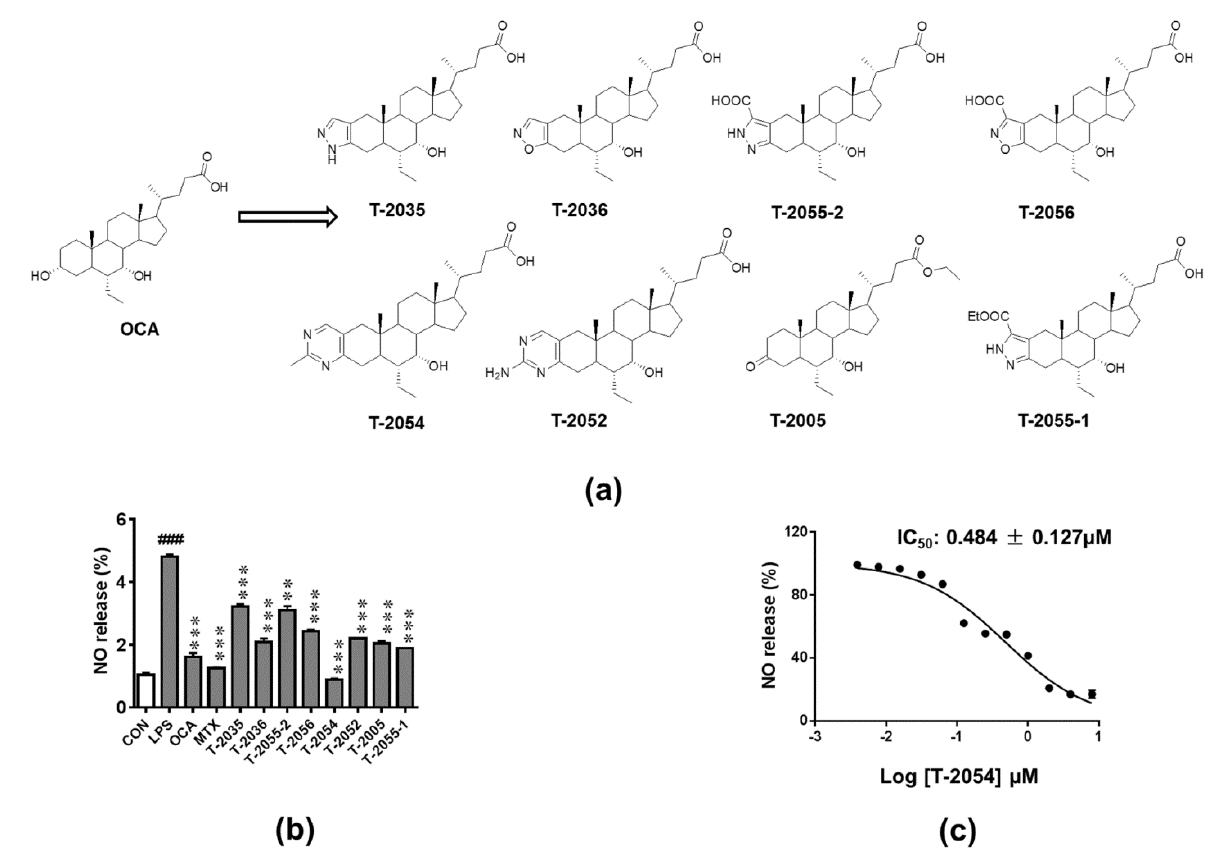
Figure 1. Detect the release of nitric oxide (NO). Structures of obeticholic acid (OCA) and OCA derivatives ( a ). The RAW-264.7 cells were pretreated with compounds and methotrexate (MTX) (0.5 μM) for 3 h before lipopolysaccharides (LPS) stimulation. 24 h later, the amounts of NO in the culture supernatants were measured by Griess agents ( b ). The NO inhibition rates curve of T-2054, with IC 50 values of 0.484 ± 0.127 μM ( c ). Each value represents the mean ± SD, performed in 3 different experiments. ### p < 0.001 vs. normal control (CON); *** p < 0.001 vs. LPS group.